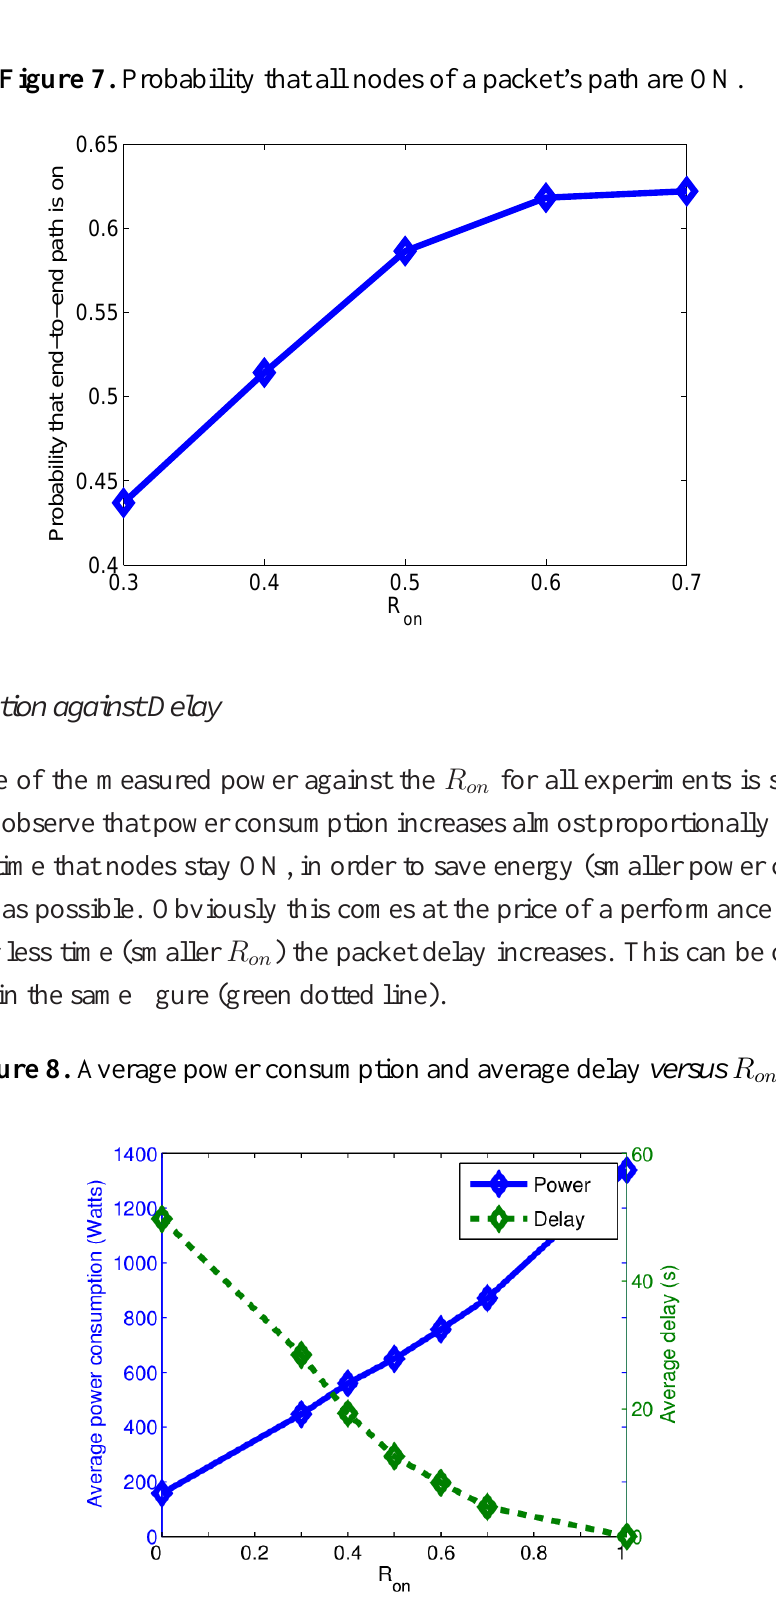
Figure 7. Probability that all nodes of a packet’s path are ON.